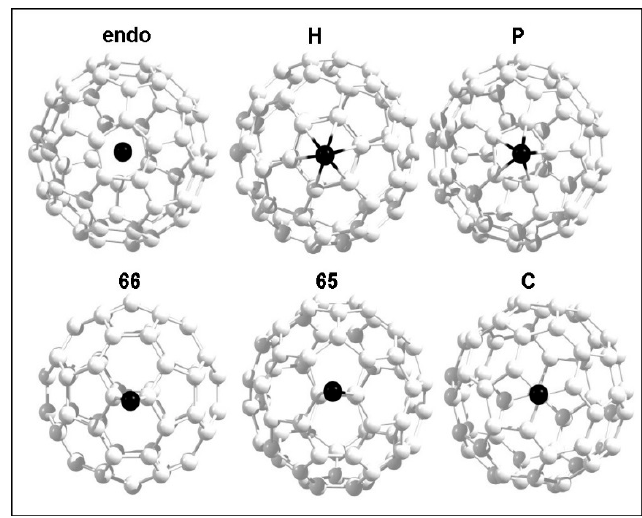
Figure 1. Initial configurations of a single metal atom interacting with a C 60 molecule .